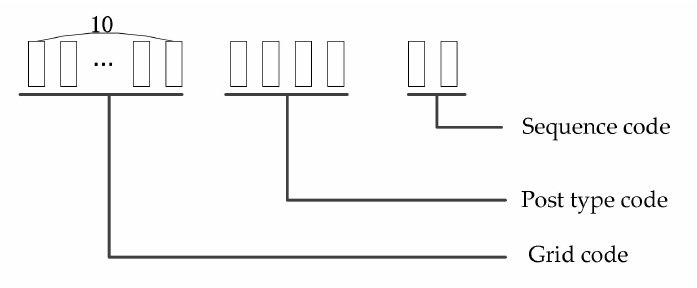
Figure 5. The code structure of grid elements in the train operation department.